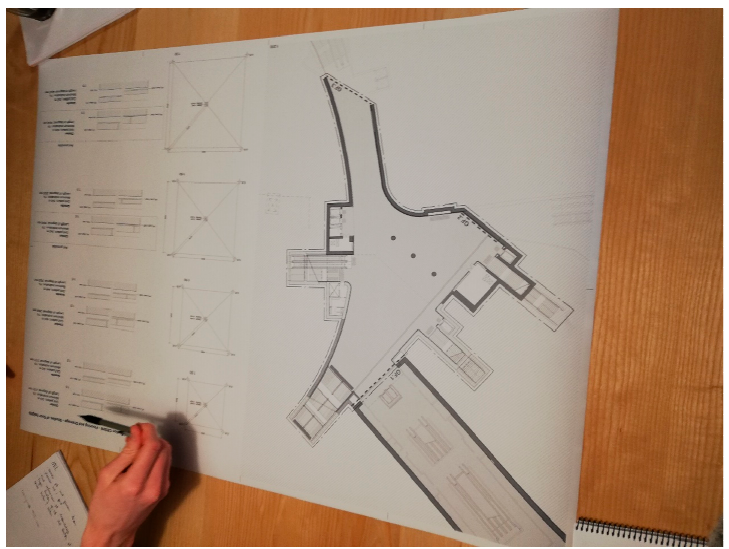
Figure 6. Floor plan of the NES concourse with tactile guidelines.